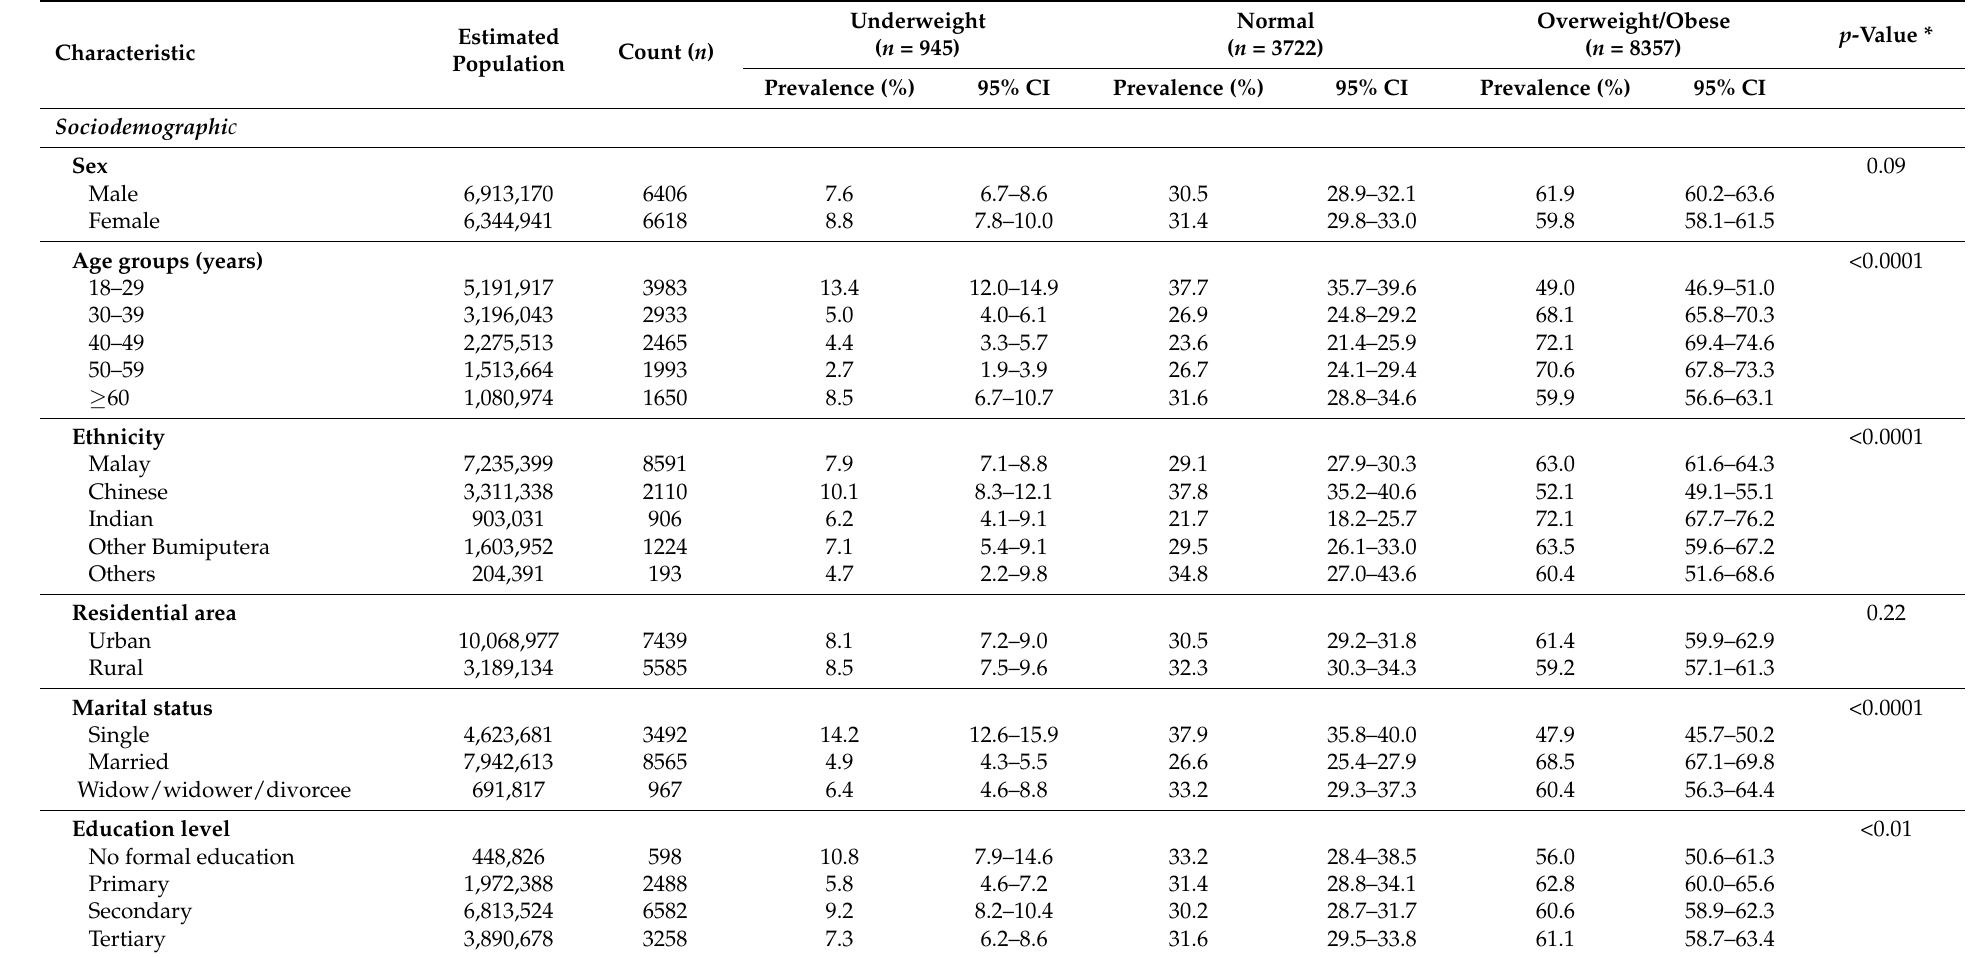
Table 2. Characteristics of the Malaysian adult respondents aged 18 years and above stratified by general obesity status ( n =